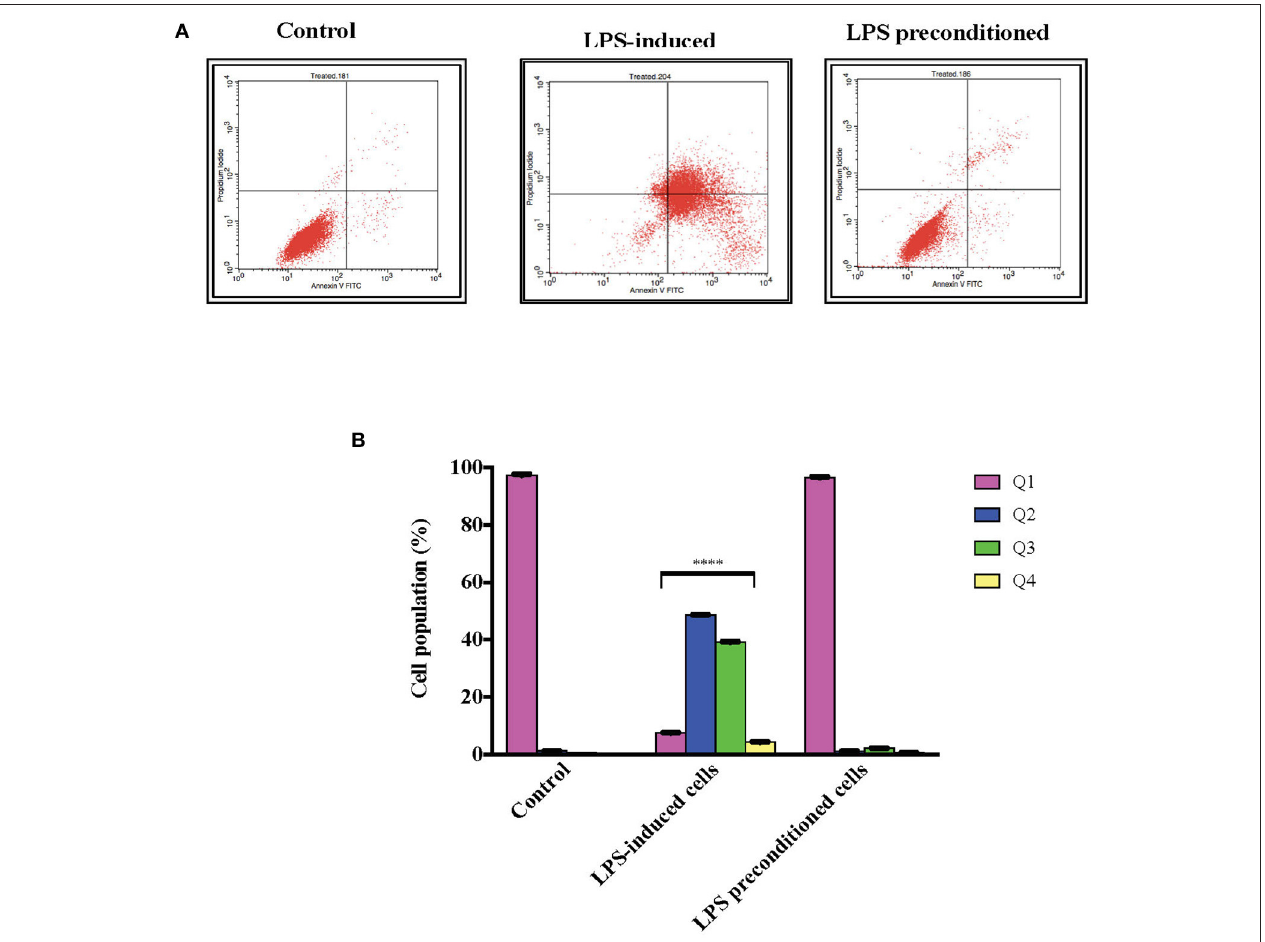
FIGURE 12 | Quantitative analysis of apoptosis progression within population in LPS-preconditioned cells by using flow cytometry. Annexin V-FITC and PI staining of the LPS-induced and LPS-preconditioned cells at the indicated time point earlier measured by flow cytometry. (A) . There is a distinct and gradual cell population shift from the lower left quadrant to the lower right, upper right, and upper left, indicating a gradual increment of cells with exposed phosphatidylserine. Q1 is the Annexin V-FITC–/PI– quadrant (intact cells), Q2 is the Annexin V-FITC + /PI– quadrant (early apoptotic cells), Q3 is the Annexin V-FITC + /PI + quadrant (late apoptotic cells), and Q4 is the Annexin V-FITC–/PI– quadrant (dead cells). Bars represent mean data ± S.E.M from three independent experiments. (B) . Data were analyzed using one-way ANOVA, followed by a Bonferroni post-hoc test. Percentage of LPS-stimulated cells was compared to the control. **** p < 0.0001 considered to be statistically